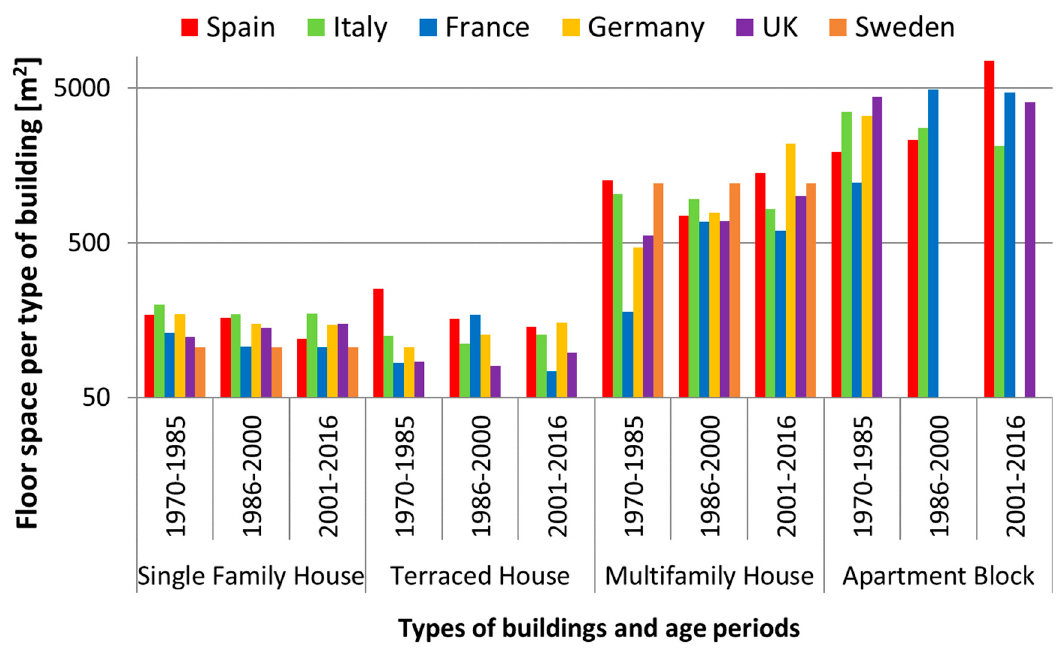
Figure 4. Average floor space per type of building by countries.